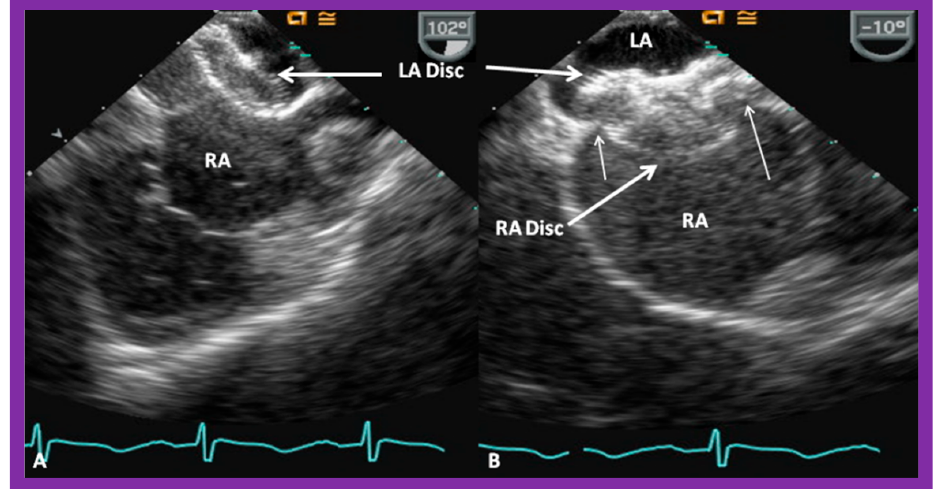
Figure 28. Transesophageal echocardiographic images during the delivery of an Amplatzer Septal Occluder in a different patient. ( A ). The left atrial disc (LA Disc) (thick arrow) was delivered into the left atrium (LA). ( B ). Both the LA and right atrial (RA) discs (thick arrows) were delivered across the atrial septal defect. Again, note the thin arrows pointing to the sandwiching of the septal rims between the LA and RA discs. The labeling notations are those used in Figure 27. Reproduced from Reference [7].